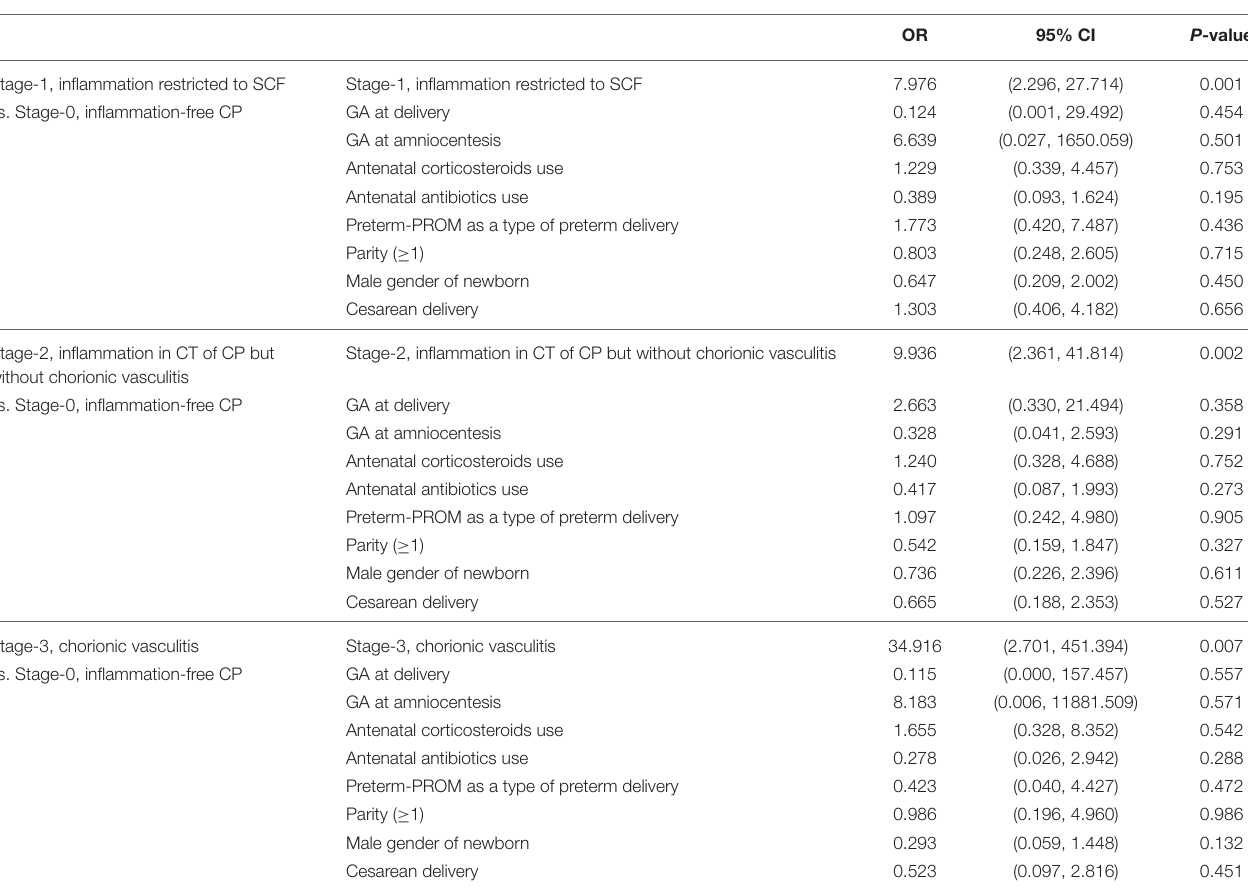
TABLE 6 | The relationship between various variables and suspected or proven early-onset neonatal sepsis (EONS) by multiple logistic regression analysis among groups according to the progression of inflammation in the chorionic plate (CP).